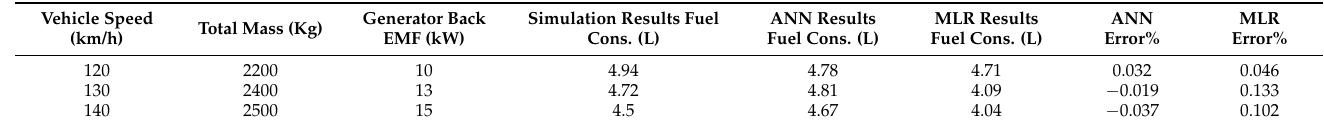
( b ) Figure 19. Effects of the parameters on ( a ) fuel consumption and ( b ) SOC. In some cases, it can be required to determine the fuel consumption results in various conditions with the variables, which may be out-of-boundary conditions. There is a need to predict the outcomes in case of out-of-boundary and various conditions. In these cases, the NN model may act efficiently to predict the results since NN can learn from previous cases. The results of three simulation and NN prediction tests were obtained for the varia- bles due to out-of-boundary conditions, as given in Table 4. It can be seen that the pro- posed neural network model also has high predictive ability in the case of out-of-the boundary conditions as compared to regression analysis. In this way, predicted values can be obtained with the ANN method in cases of out- of- boundary conditions in future projects. It can be stated that prediction of an energy- management strategy using a neural-network-based surrogate model can be achieved by adapting the operating strategy according to different loading conditions to reduce fuel consumption for REX. 5. Conclusions In this research, an approach based on a NN-based surrogate model was developed for new vehicle projects by transforming the prototype light commercial electric vehicle to REX. The proposed approach was developed to design the most efficient range-ex- tended vehicle by changing all variables without costly computations and time-